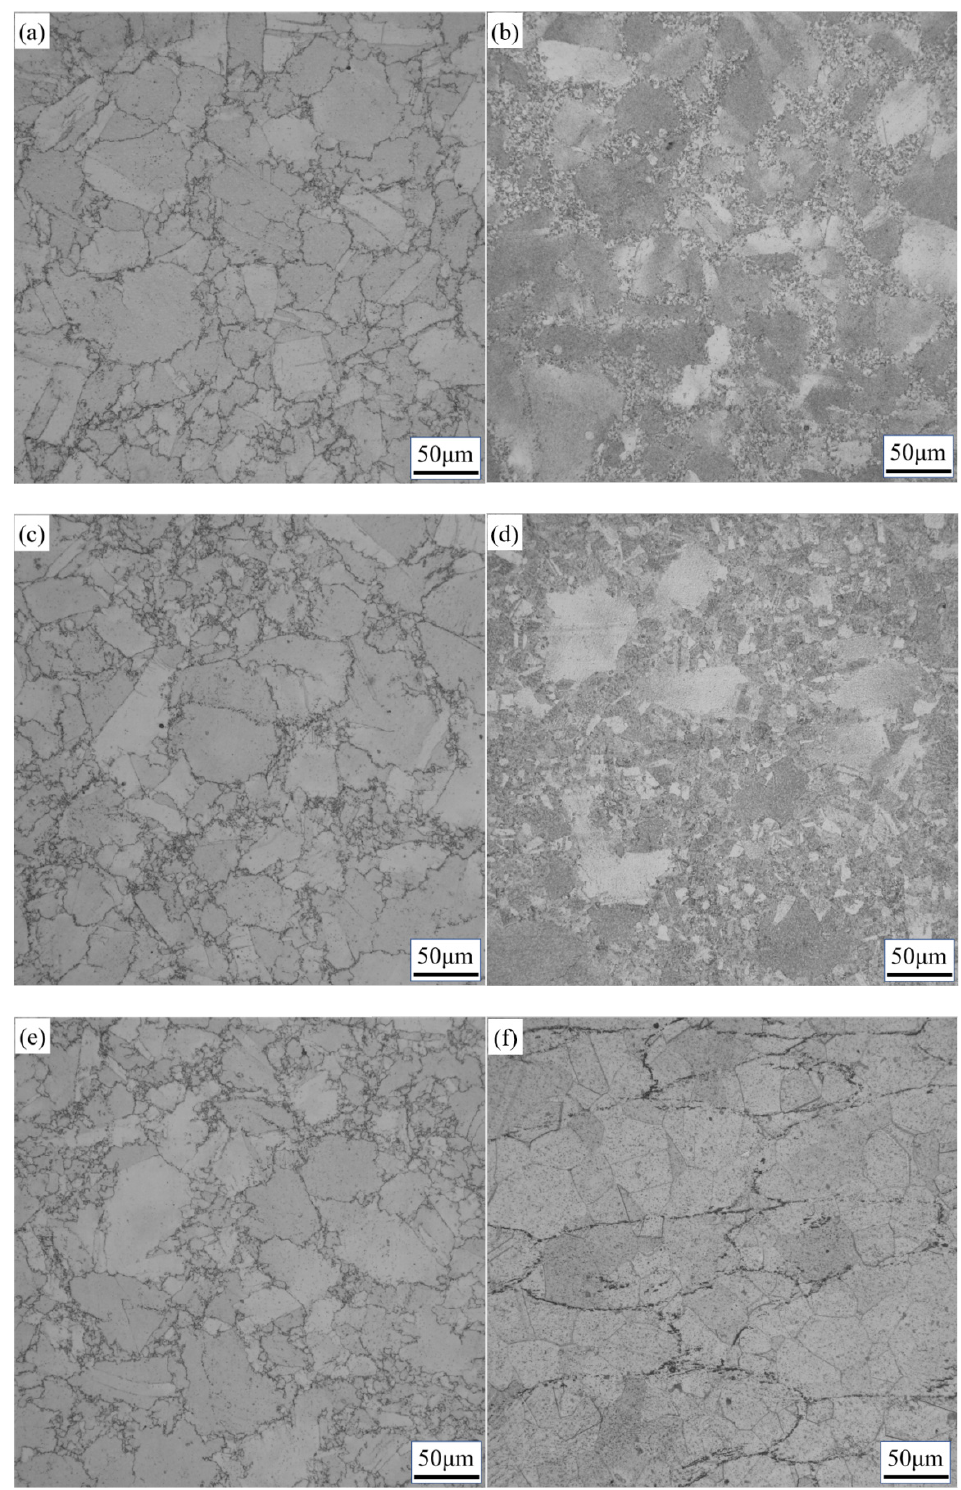
Figure 2. Influence of solution treatment temperature on size distribution of grain: ( a , c , e ) before solution treatment and ( b , d , f ) after solution treatment for 10 h; ( b ) 1060 °C, ( d ) 1080 °C, and ( f ) 1100 °C.